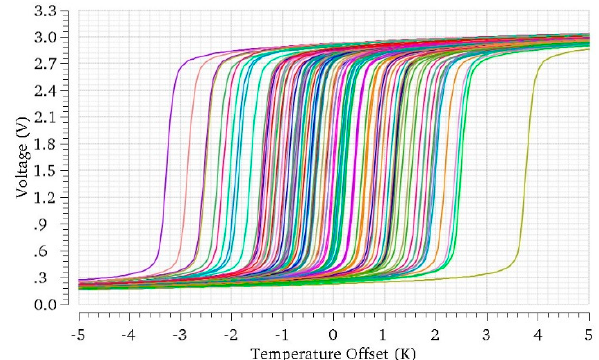
Figure 8. Simulation of the core sensor in Figure 6, at balance ( Δ T Q = 0 K) for several occurrences of the random variations of the components in the circuit.